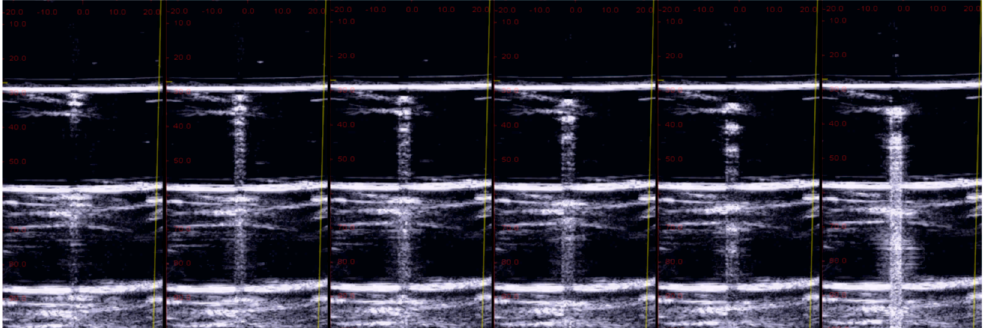
Figure 3. Example frames from a video clip during which a drop of water was acquired, with a linear US probe, while it was falling from a water container. From left to right, the number of observed reverberations and their spacing increase. The last frame shows how the trap acoustic sign changes radically (it appears brighter and much longer) when the drop reaches the necessary weight to detach and fall.